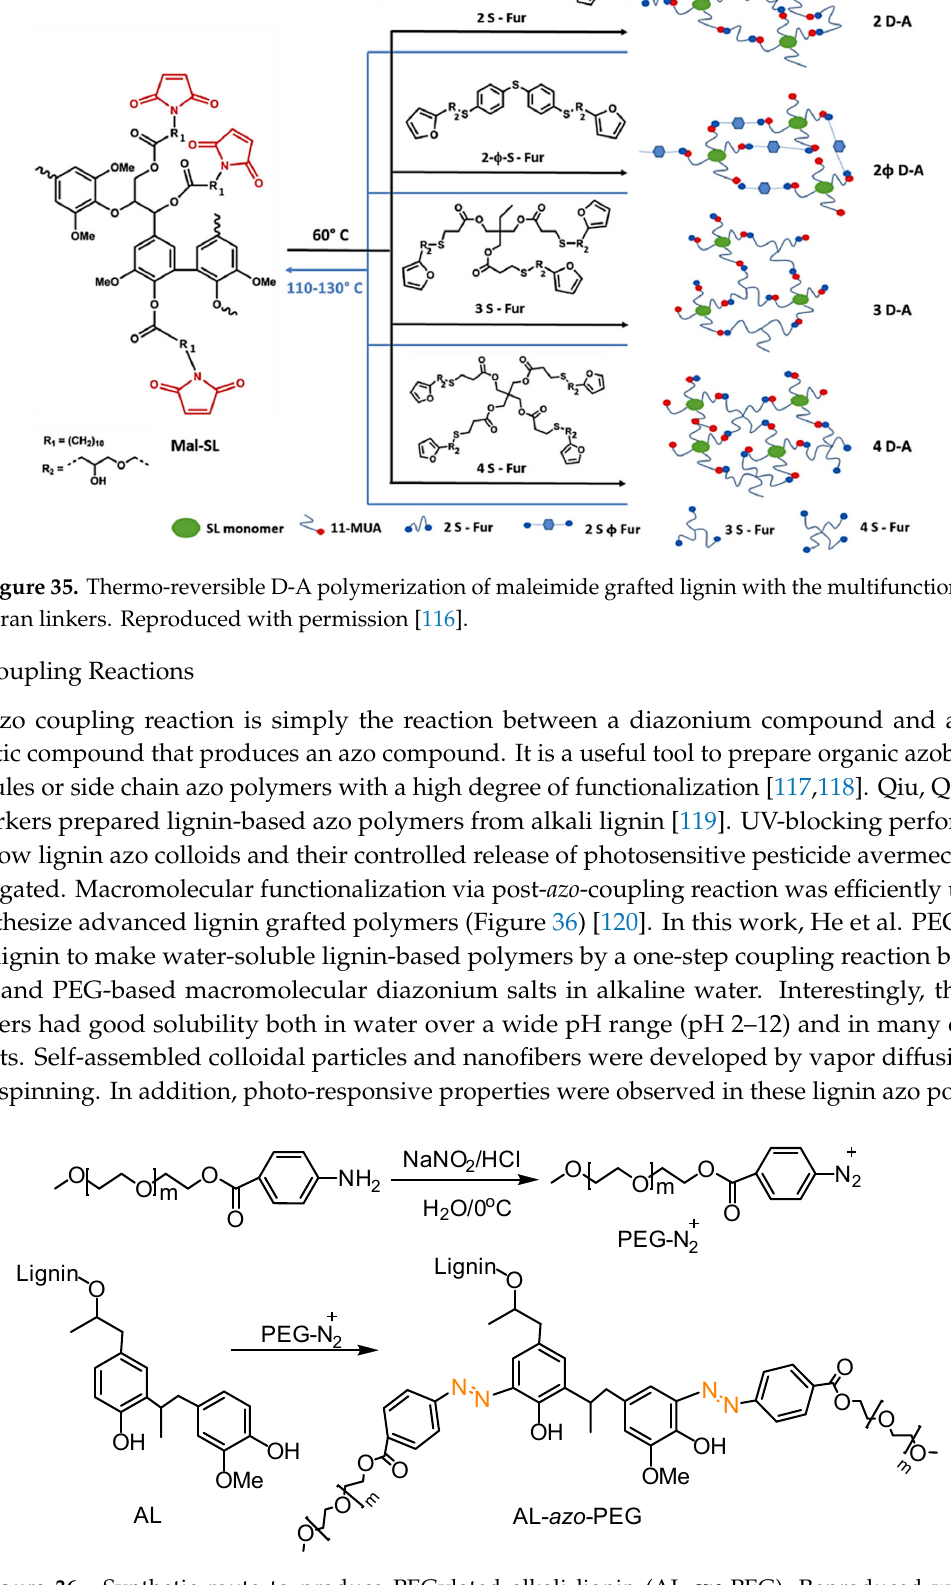
Figure 36. Synthetic route to produce PEGylated alkali lignin (AL- azo -PEG). Reproduced with permission